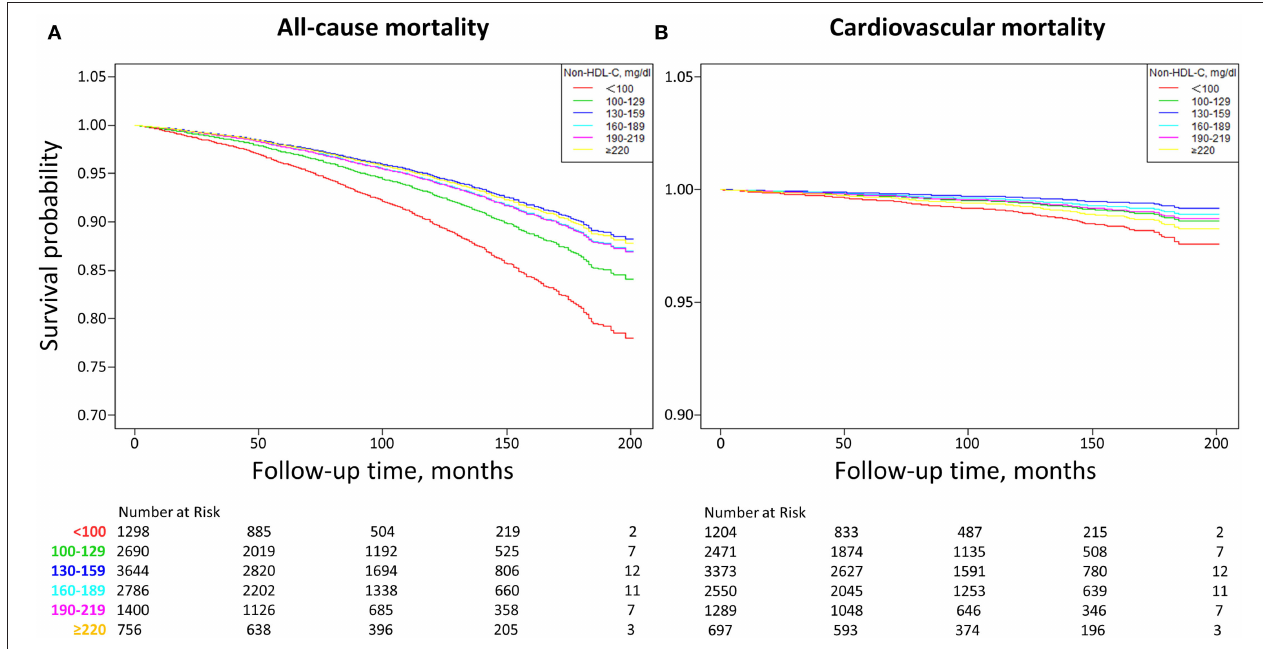
FIGURE 2 | Kaplan-Meier survival curves of non-HDL-C with all-cause (A) and cardiovascular (B) mortality. Non-HDL-C, non-high-density lipoprotein cholesterol. (A) Other groups vs. non-HDL-C < 100 mg/dl (all P < 0.005). (B) non-HDL-C = 130–159 or 160–189 mg/dl vs. non-HDL-C < 100 mg/dl (all P < 0.005), non-HDL-C = 100–129 mg/dl vs. non-HDL-C < 100 mg/dl ( P = 0.0443), non-HDL-C = 190–219 mg/dl vs. non-HDL-C < 100 mg/dl ( P = 0.0546), non-HDL-C ≥ 220 mg/dl vs. non-HDL-C < 100 mg/dl ( P = 0.3687).